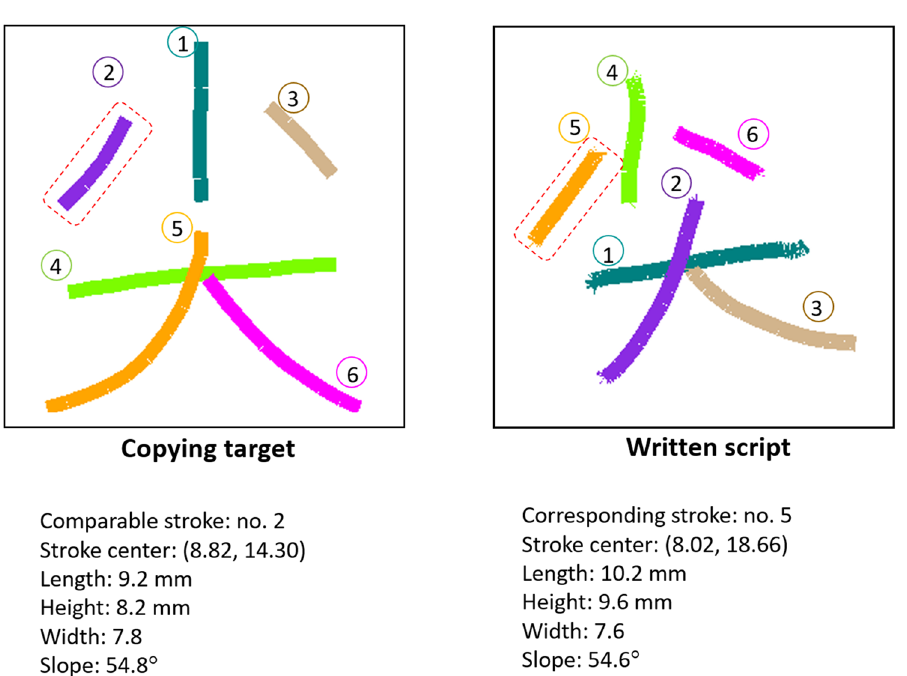
Figure 2. The comparison between copying target and written script. Given as an example, the parameters of the second stroke of the copying target are compared with the corresponding stroke of the written script (no.